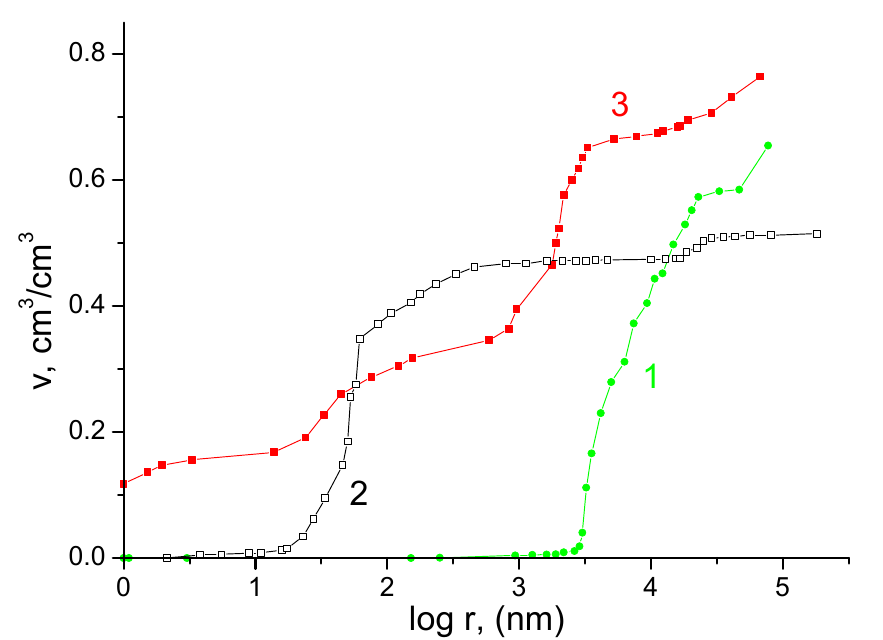
Figure 2. Integral porometric curves obtained by MSCP for: 1—separator FS 2226; 2—Grace separa- tors; 3—KU-F5-240 membranes.